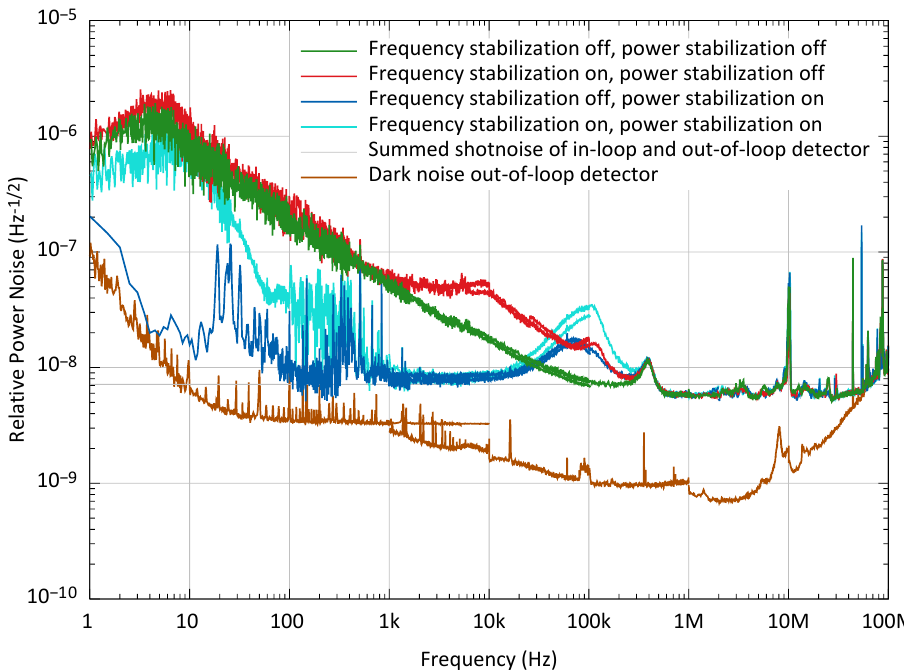
Figure 14. The RPN as an amplitude spectral density was measured for several combinations of on/off states of the frequency and power stabilization control loops. A cross-coupling between frequency stabilization to power noise is